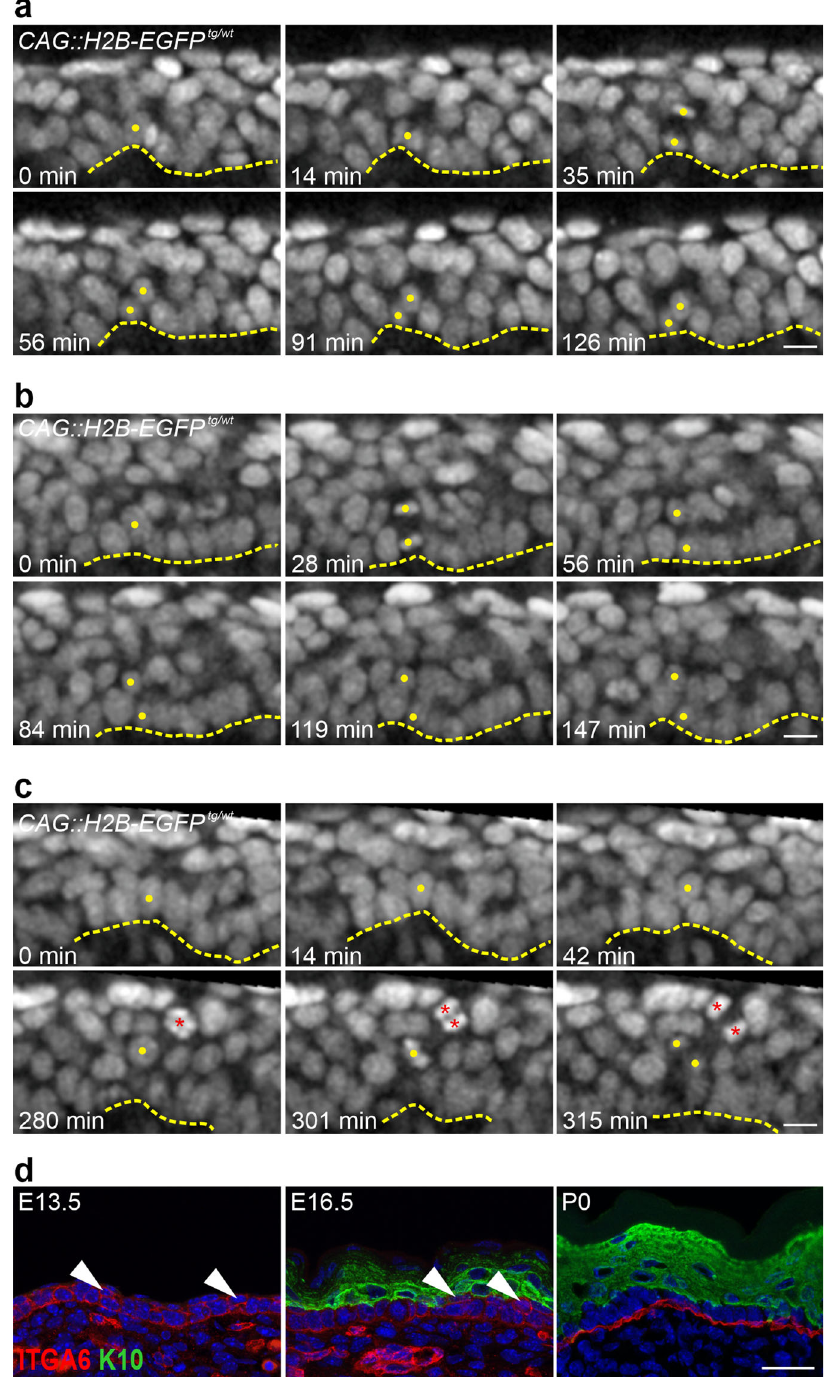
Fig. 5 The skin epidermal basal layer is more fl exible during development. a – c Time-lapse images of the CAG::H2B-EGFP nuclear reporter (gray) in E13.5 – E14.5 skin-roll explants taken every 7 min. a , b Examples of perpendicular dividing basal cells with daughter cells that point away from the epidermal- dermal interface that was either integrated into the basal layer after division (( a ), 44 out of 94 cells), or remained in the second layer for the duration of the analysis (( b ), 50 out of 94 cells). c An Example of a delaminating cell that left the basal layer moved suprabasally and divided (a total of 46 cells observed). Note the other dividing suprabasal cell (red asterisks) (scale bars: 10 µ m). The data were obtained from fi ve explants taken from fi ve different embryos in fi ve independent imaging experiments. The dashed line represents the epidermal-dermal interface in all panels. Yellow dots mark the cells of interest. d Immunostaining of back-skin sections at the indicated stages stained for ITGA6 (red) and K10 (green) (scale bar: 25 µ m). Arrowheads indicate cells in the second layer that are positive for ITGA6 but negative for